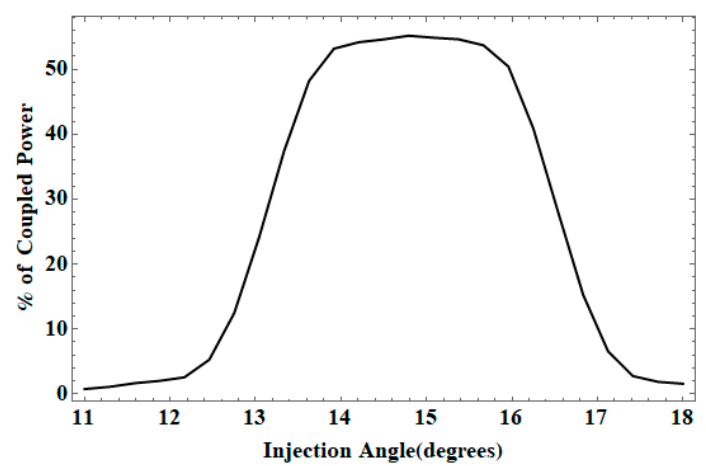
Figure 6. Injection angle as a function of coupled power.